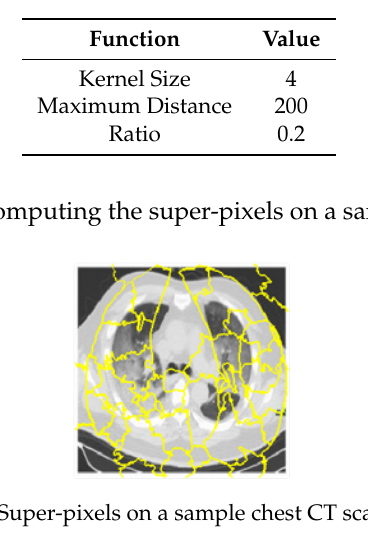
Table 11. Parameter used to calculate maximum pixels.